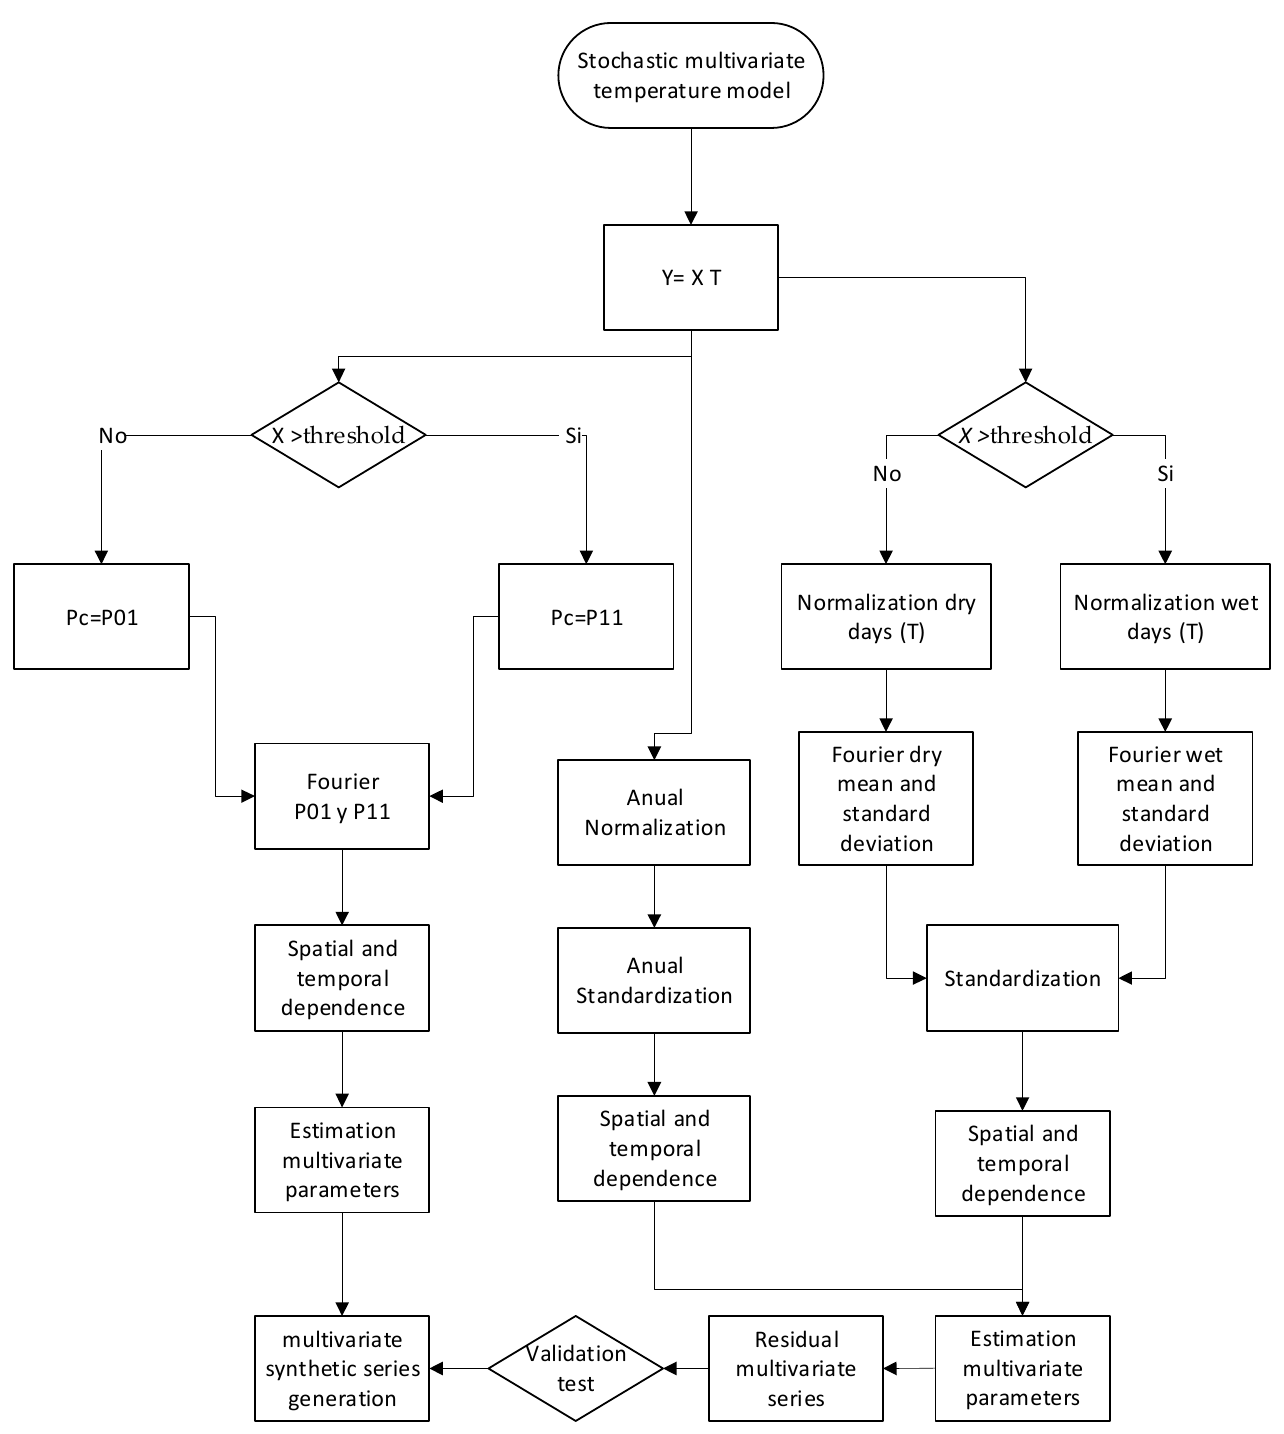
Figure 1. Proposed methodology for multisite multivariate precipitation occurrence, daily and annual temperatures.